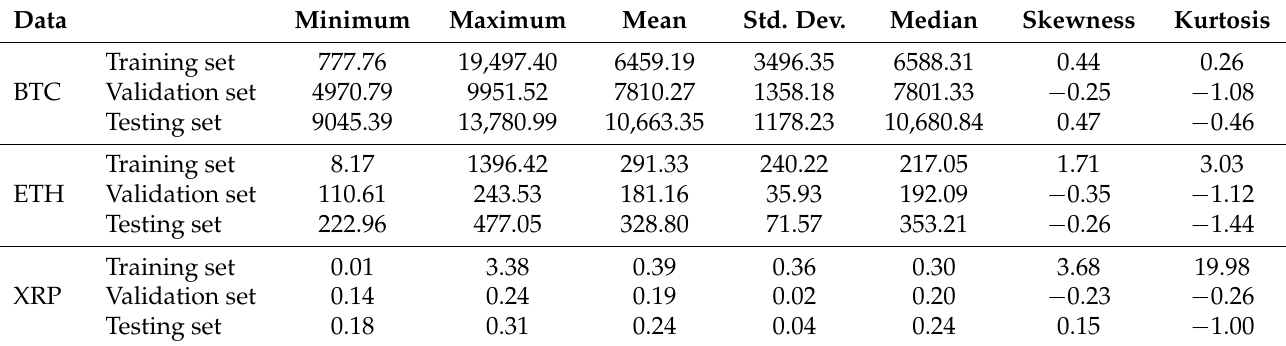
( c ) Ripple Figure 2. Daily price of cryptocurrencies Bitcoin (BTC), Etherium (ETH), and Ripple (XRP) in USD from 1 January 2017 to 31 October 2020. Table 1. Descriptive statistics for BTC, ETH, and XRP data.